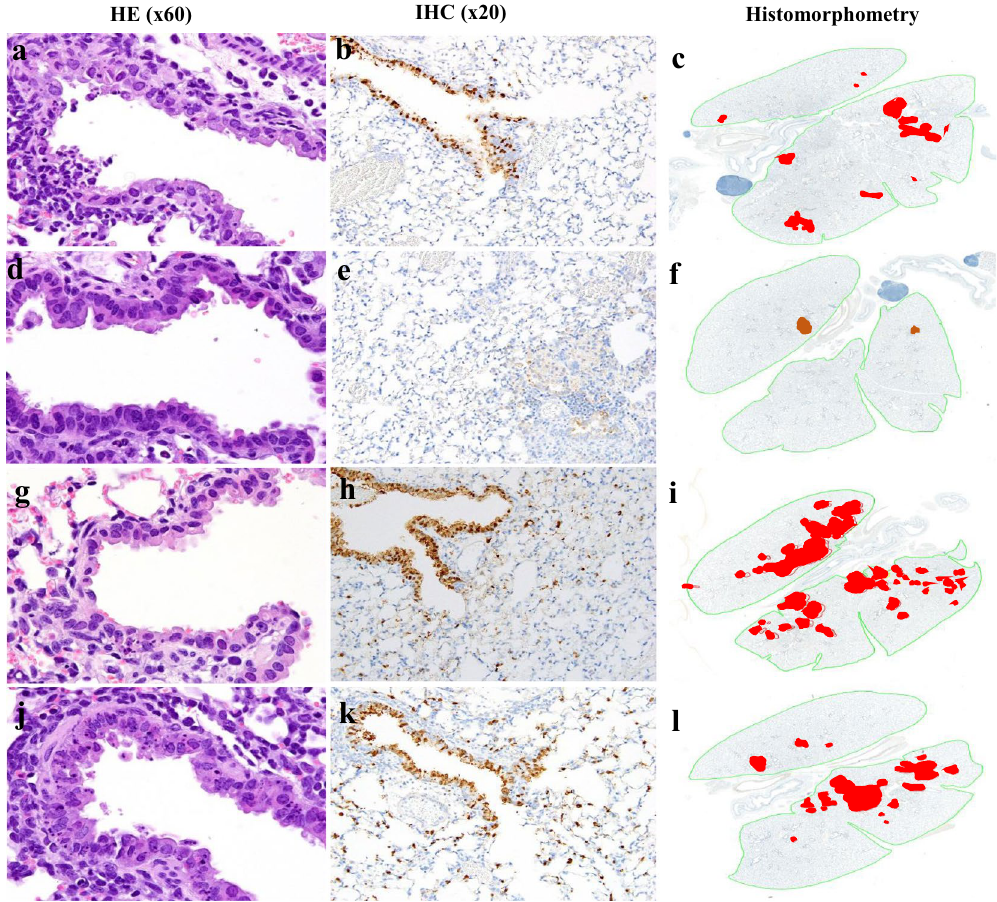
Figure 4. Pulmonary lesions and viral spread in the lungs of AIV-infected mice. Lungs infected with DK/ BD821/09 H10N7 ( a – c ) showed scattered degenerating bronchiolar epithelial cells in terminal airways (a) but positive immunohistochemical (IHC) staining for viral antigen was mostly limited to bronchiolar epithelium (b) with only minimal spread to surrounding alveoli (c) . Following infections with DK/BD8988/10